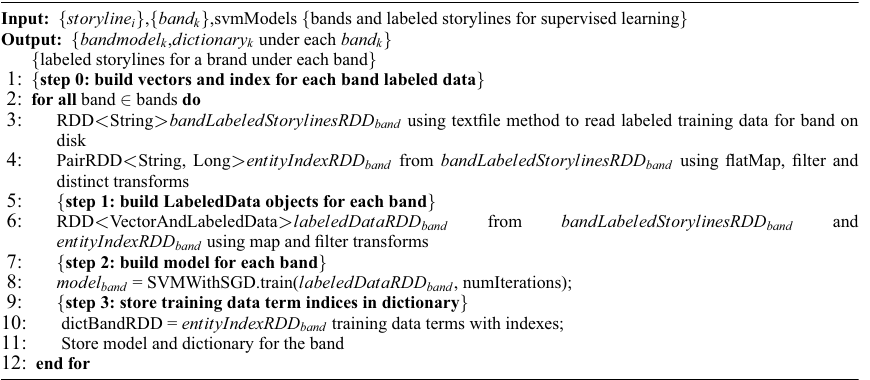
Algorithm 1 Generate classifiers from training data